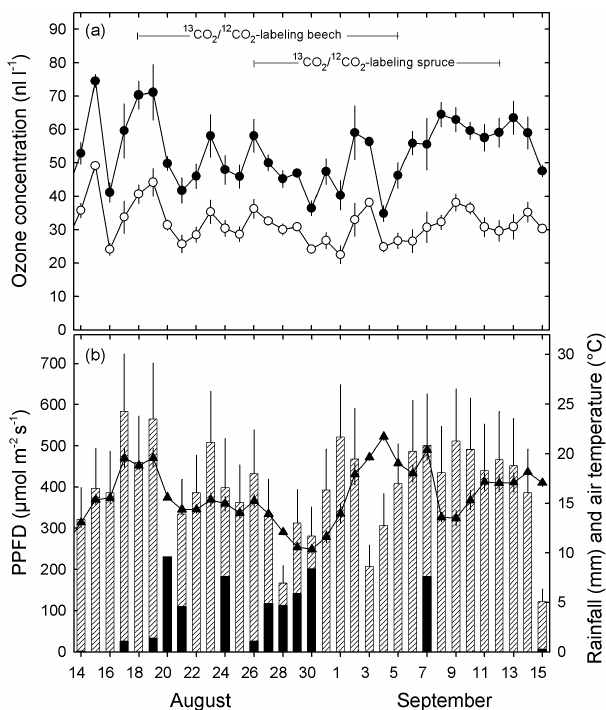
Fig. 1. Ozone concentrations and weather conditions during la- bel exposure. (a) 1 × (open circles) and 2 × O 3 (closed circles). (b) Daily sums of photosynthetic photon flux density (PPFD) given as means of daylight hours ± SE (hatched bars), daily means of air temperature ( ± SE, triangles) and sums of rainfall (black